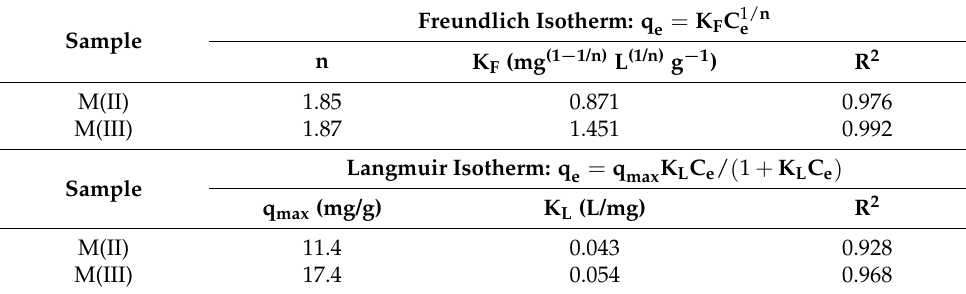
Table 2. Fitted parameters of Langmuir and Freundlich Models.